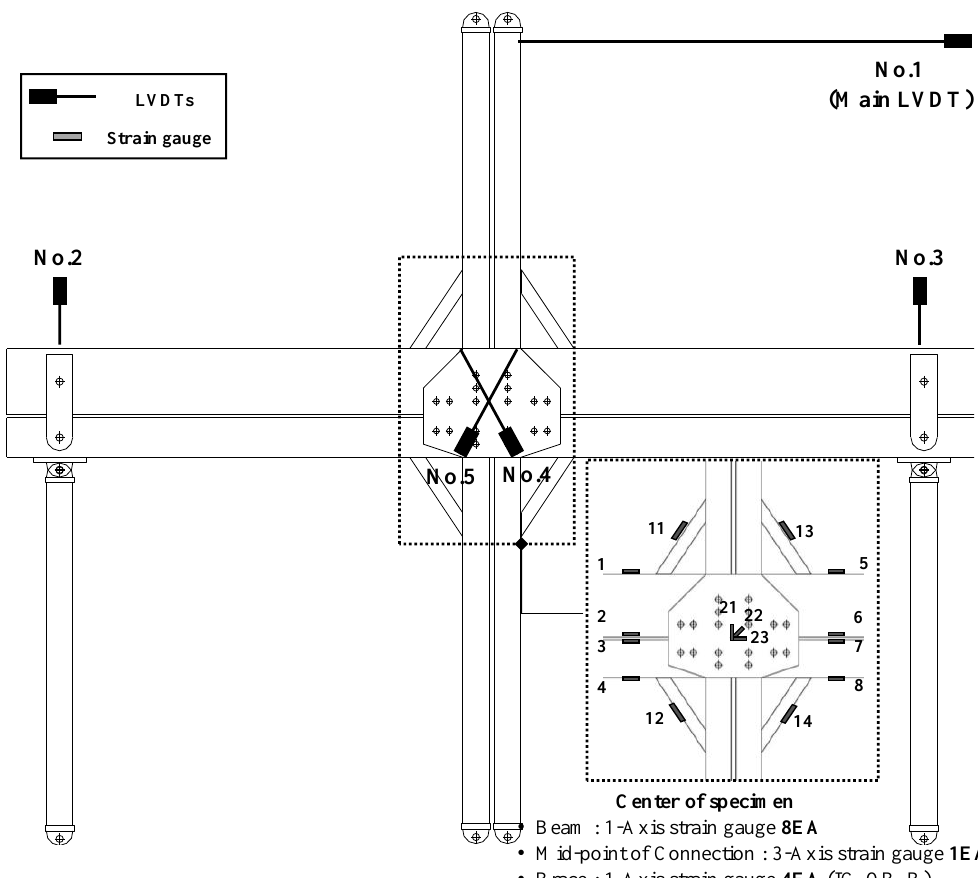
Figure 10. Schematic illustration of a linear variable differential transducer (LVDT) and strain gauge setup.